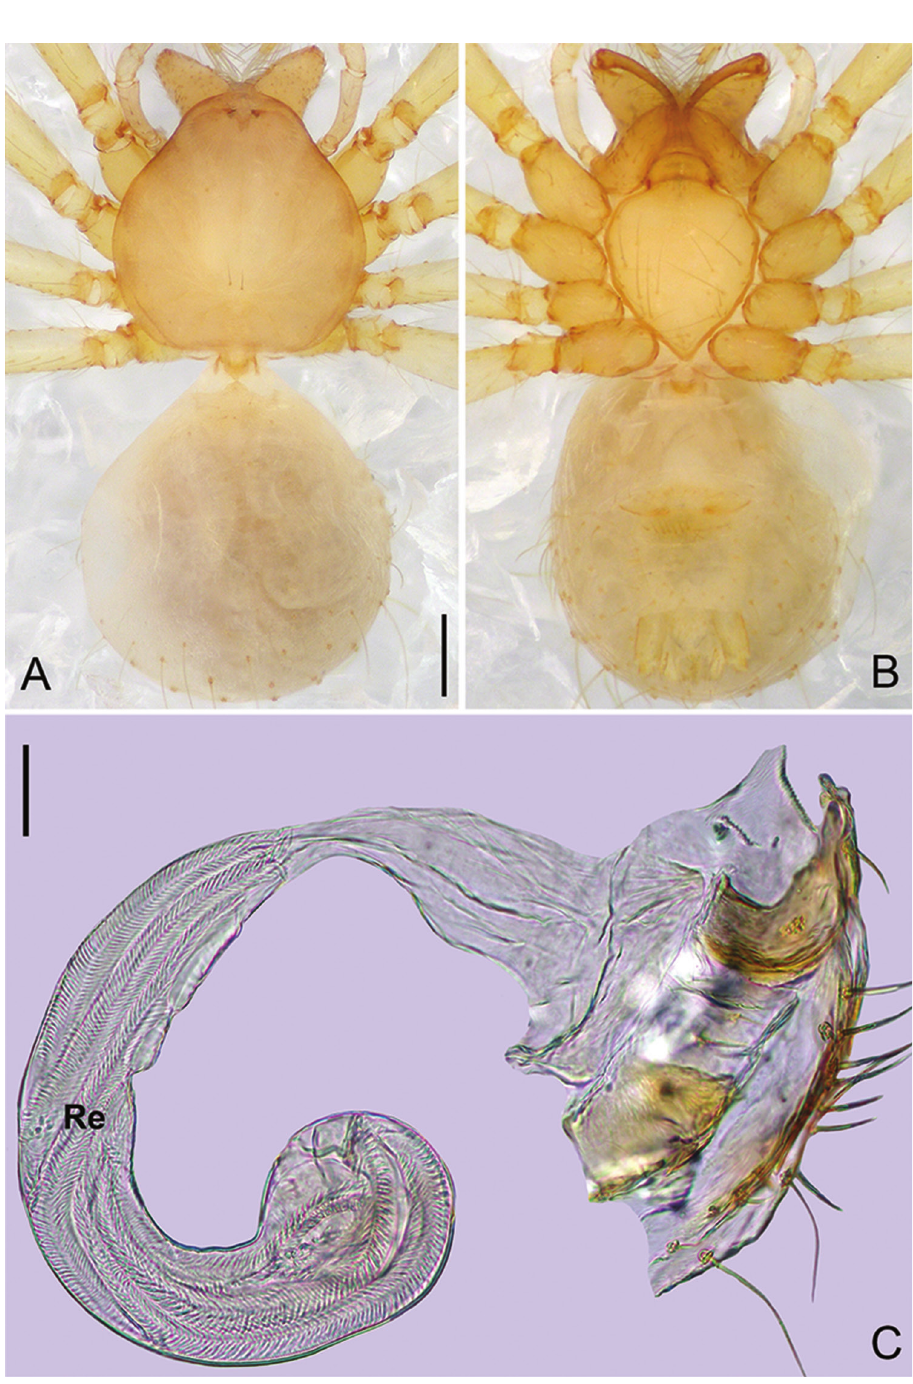
Figure 30. Pinelema zhewang , female. A Habitus, dorsal view B Habitus, ventral view C Endogyne, lateral view. Scale bars: 0.2 mm ( A–B ), 0.05 mm ( C